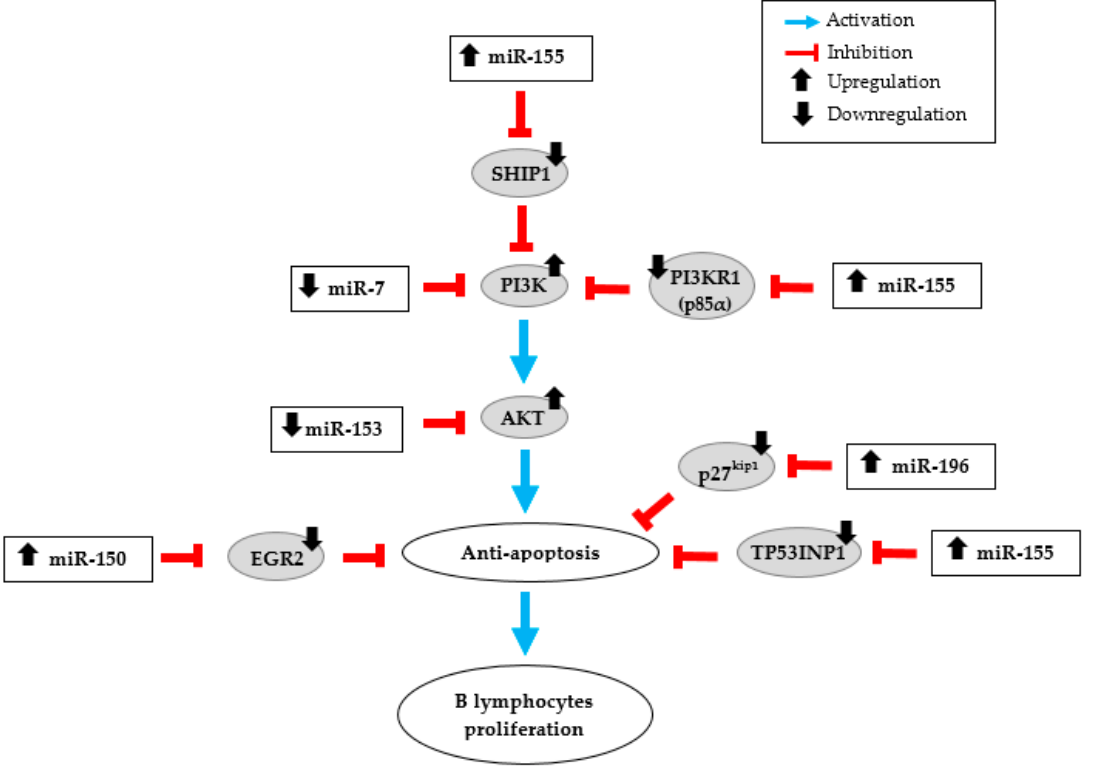
Figure 3. miRNA dysregulation in human gastric MALT lymphoma (GML). Schematic illustration of the potential action network of validated targets of miRNAs overexpressed (miR-155, miR-150 and miR-196) or down-regulated (miR-7 and miR-153) in GML patient stomachs.